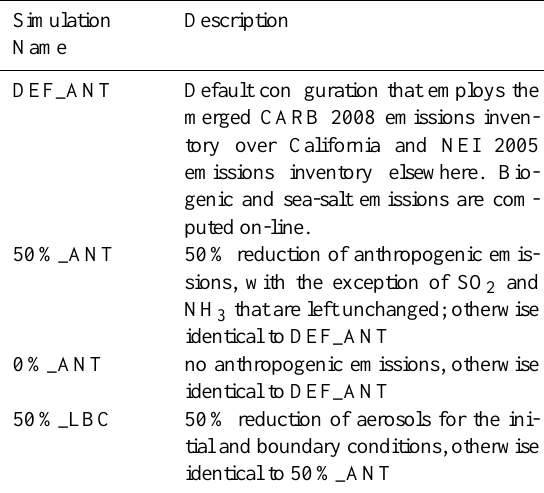
Table 3. Description of simulations performed for this